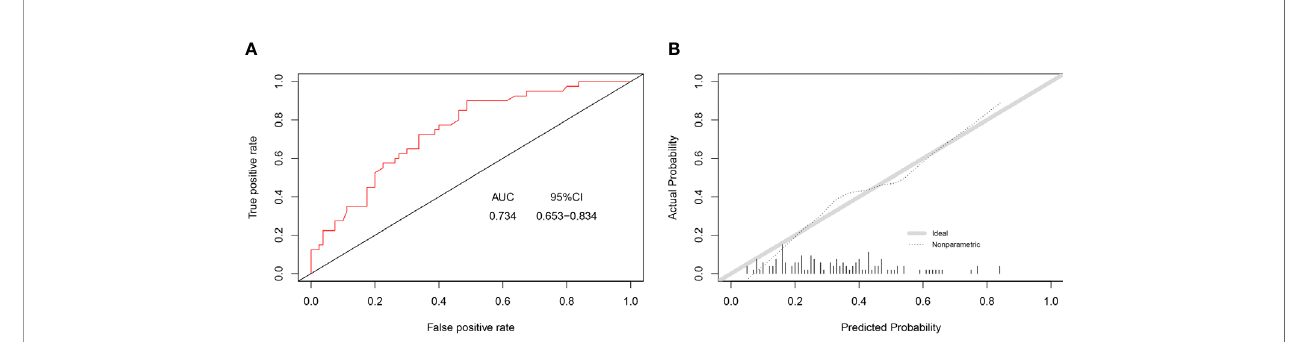
FIGURE 6 | AUC values of ROC predicted multiple metastases (A) . The calibration curve of predictive nomograms for predicting multiple metastases (B) . (panel A ) AUC, area under the curve; 95CI%, 95% con fi dence interval. (panel B ) Ideal, Ideal calibration curve; Non-parametric, Actual calibration curve of